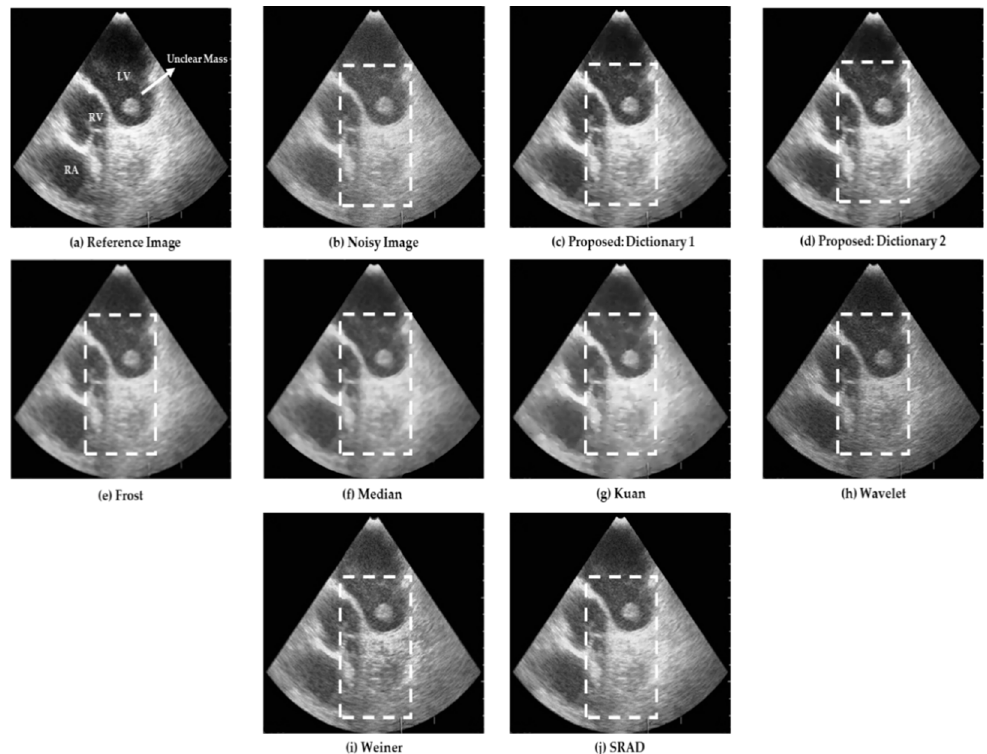
Figure 9. ( a ) Ultrasound image of the thrombus in the left ventricle. LV: left ventricle, RA: right atrium and RV: right ventricle and ( b ) noisy image. Despeckled ultrasound images of proposed method using ( c ) Dictionary 1 and ( d ) Dictionary 2. Results using the ( e ) Frost, ( f ) median, ( g ) Kuan, ( h ) wavelet, ( i ) Weiner, and ( j ) SRAD filters. The dashed white box indicates the region of image showing visual enhancement owing to despeckling. Appl. Sci. 2018 , 8 , x FOR PEER REVIEW